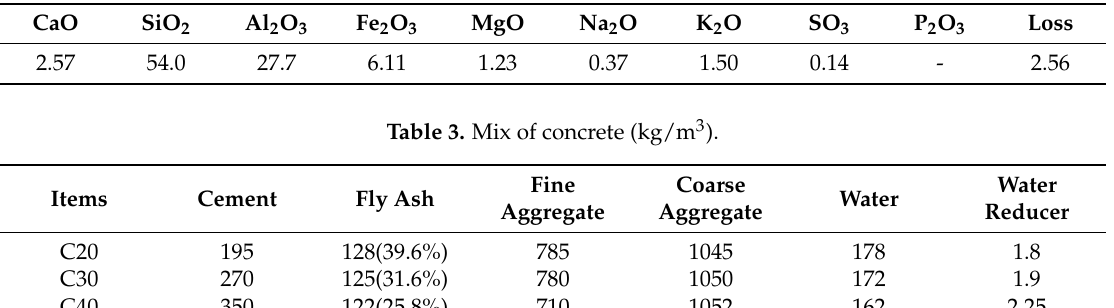
Table 2. Chemical compositions of fly ash (%).